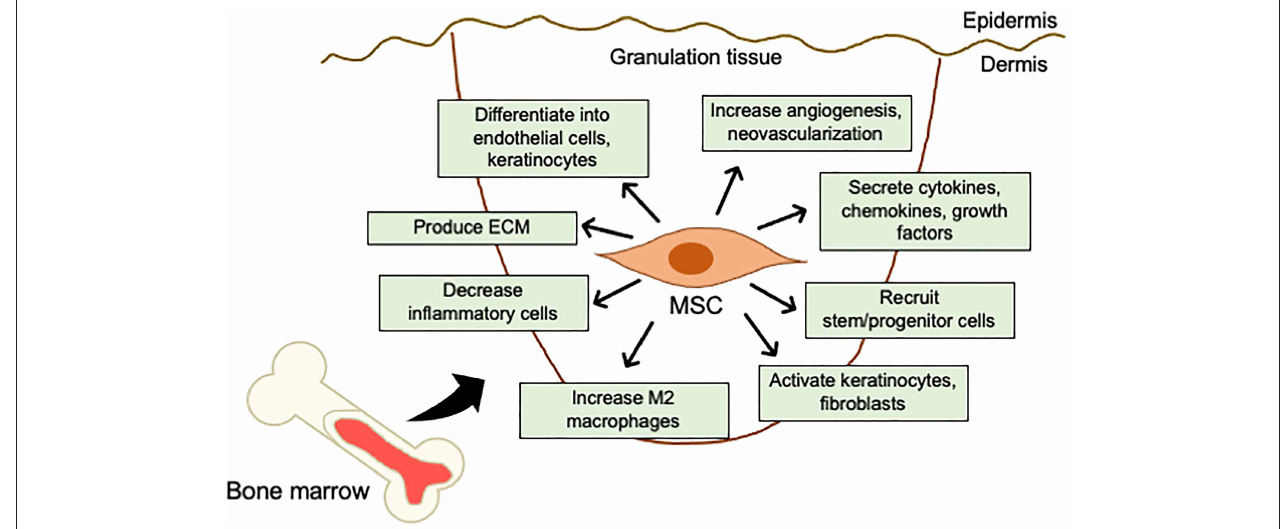
FIGURE 2 | Mechanistic roles of MSCs in the skin wound healing. Mechanisms of acceleration of wound healing by MSCs; (i) activation of keratinocytes and fibroblasts, (ii) increase in angiogenesis and neovascularization, (iii) increase in M2 macrophages infiltration, (iv) recruitment of stem/progenitor cells, (v) secretion of cytokines and growth factors, (vi) production of ECM, (vii) decrease in inflammatory cytokine levels by immunosuppressive effects, and (viii) differentiation into endothelial cells, fibroblasts, and keratinocytes.